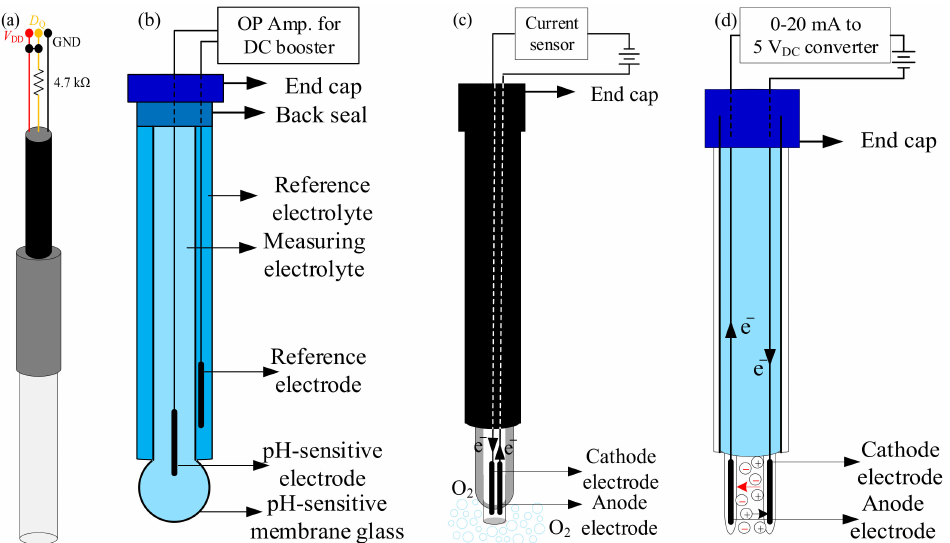
Figure 3. Schematics of sensors: ( a ) DS18B20 temperature sensor; ( b ) pH sensor; ( c ) DO sensor; and ( d ) EC